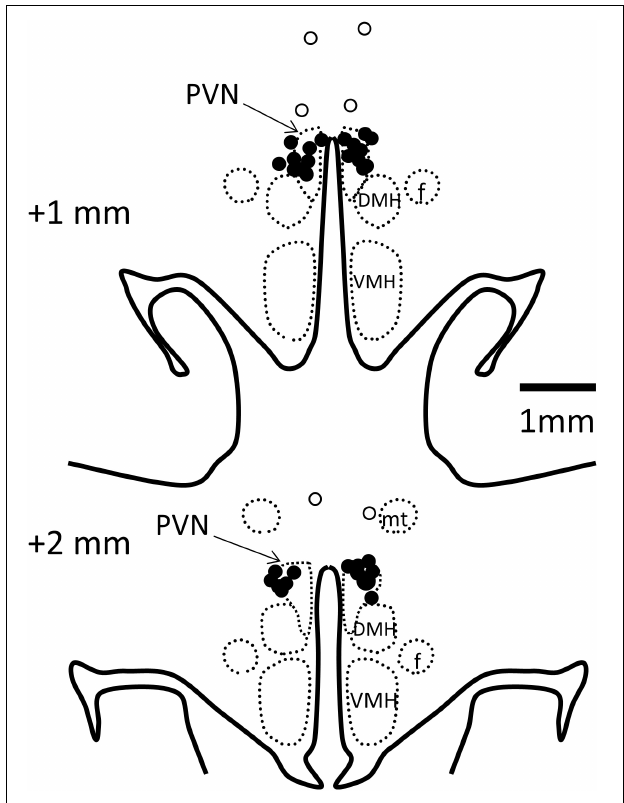
FIGURE 2 | Schematic representation of microinjection sites. Coronal sections at 1 and 2 mm posterior to bregma with bilateral microinjection sites shown as filled circles when in the paraventricular nucleus (PVN, indicated by arrows, n = 19) and open circles when outside ( n = 3). Injection sites in 1 other rabbit were outside the PVN, not visible on these sections. DMH, dorsomedial hypothalamus; VMH, ventromedial hypothalamus; f, fornix; mt, mammillothalamic